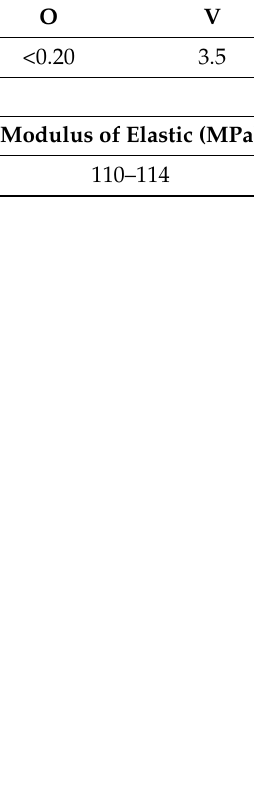
Table 1. Chemical composition and mechanical properties of Ti6Al4V titanium alloy, According to ISO 5832-3:2016. Chemical Composition